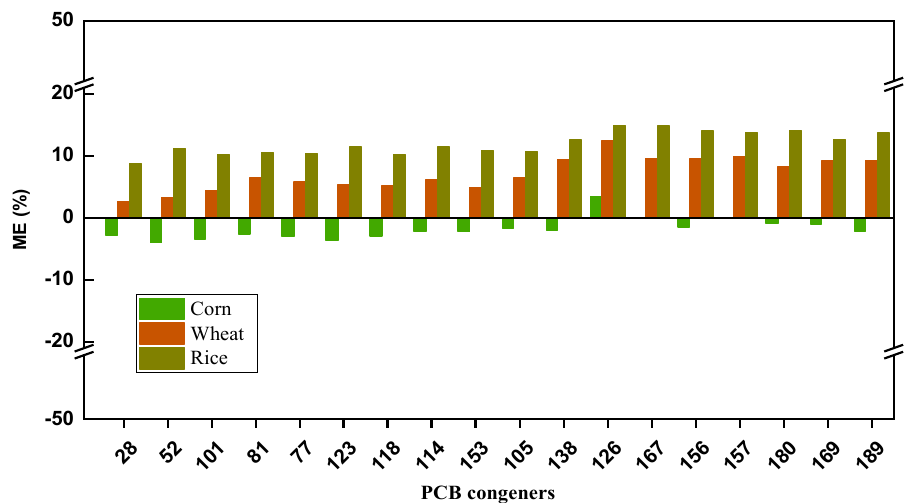
Figure 6. The matrix effects of 18 PCBs in corn, wheat, and rice.